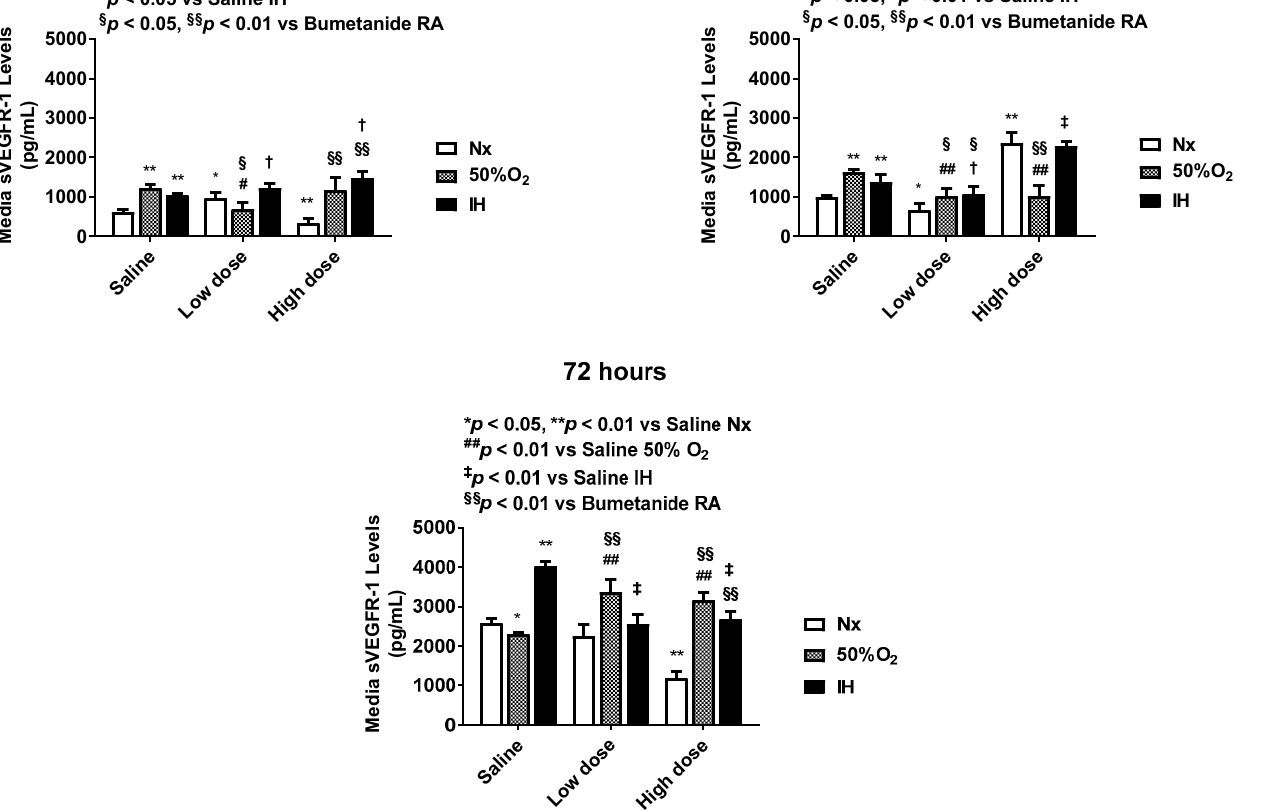
Figure 5. Dose-response effect of bumetanide on soluble VEGF receptor (sVEGFR)-1 levels in the media from cultured human microvascular retinal endothelial cells (HMRECs) exposed to normoxia (white bar), hyperoxia (50% O 2 , shaded bar), or intermittent hypoxia (IH, black bar) for 24, 48, or 72 h. Data were analyzed using two-way ANOVA with Dunnett’s post hoc test. Data are mean ± SEM (8 samples/group). * p < 0.05, ** p < 0.01 versus saline RA; # p < 0.05, ## p < 0.01 versus saline 50% O 2 ; † p < 0.05, ‡ p < 0.01 vs. saline IH; and § p < 0.05, §§ p < 0.01 versus bumetanide treatment in RA.